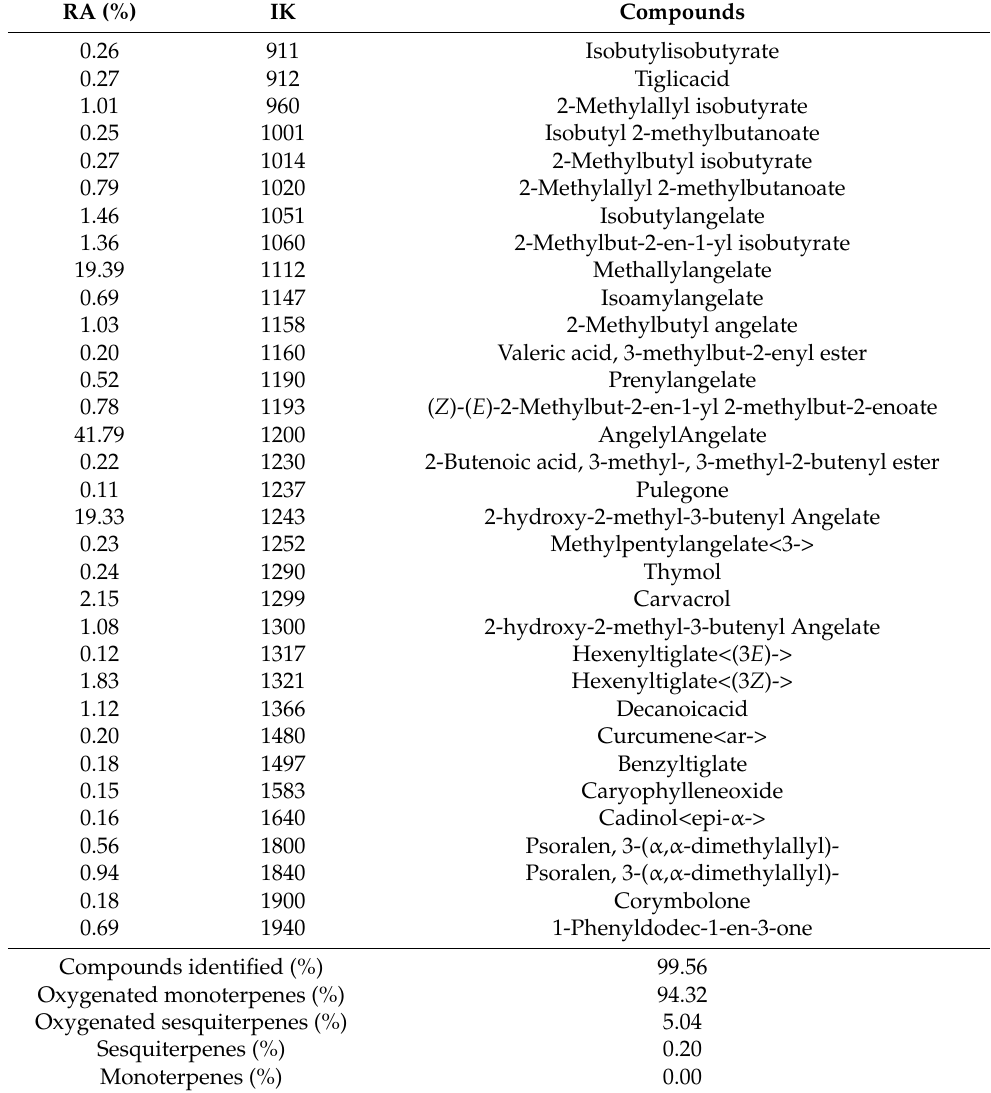
Table 6. The chemical composition of EO of C hamaemelum nobile